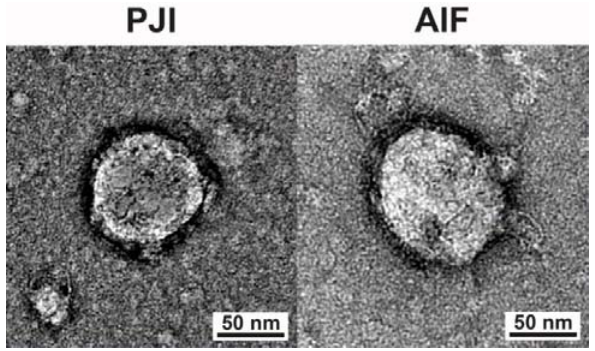
Figure 2. Selected representative electron microscopy images evidencing extracellular vesicle presence in both groups.